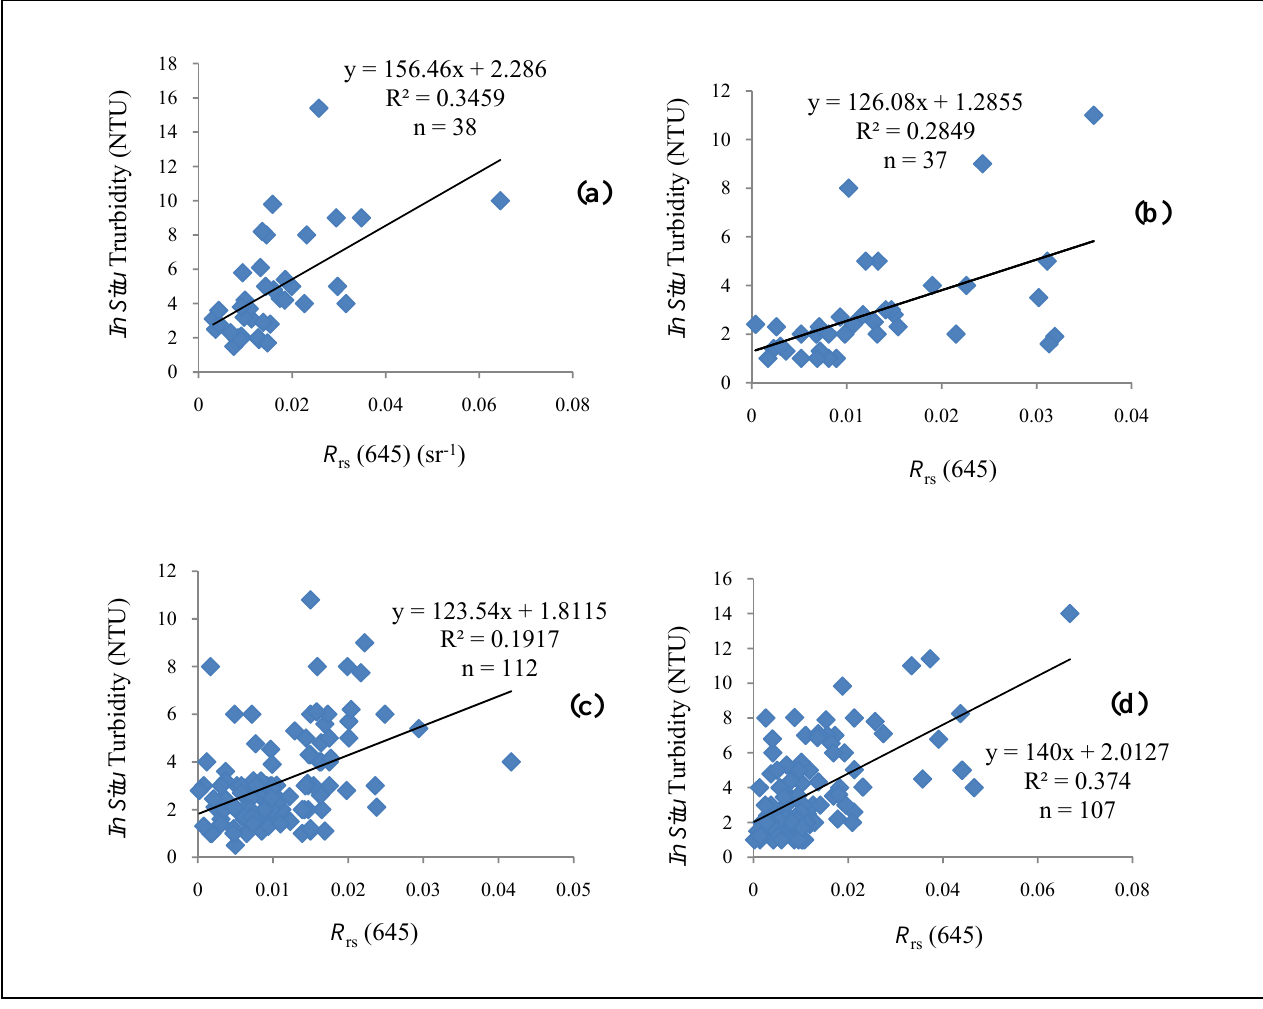
Figure 5. R elationships between in situ Turbidity (NTU) and R sub-region and considering all matched up pairs available (regarding less of days